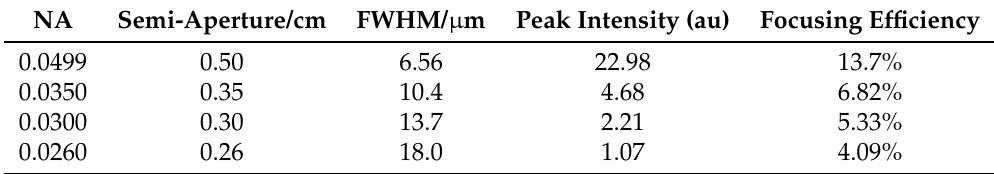
Table 3. Simulated data for the 632.8 nm